Question: What visual encoding does this figure use to show its data?
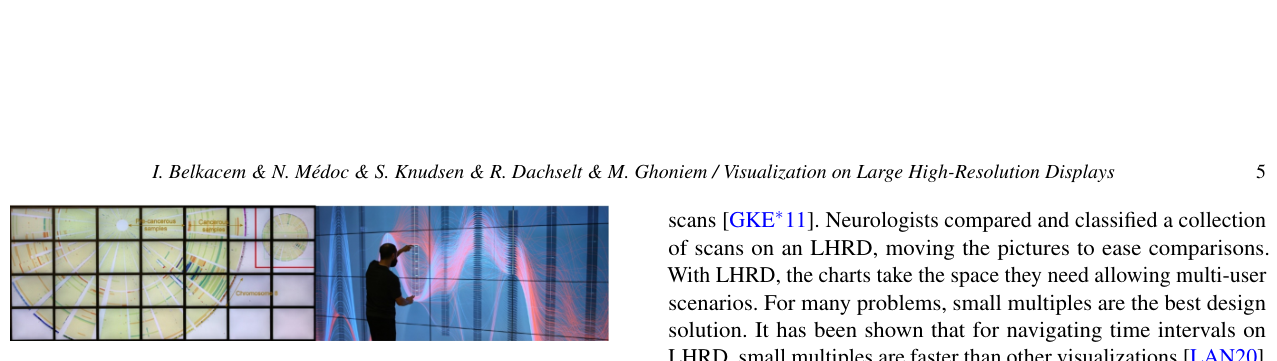
Answer: heatmap